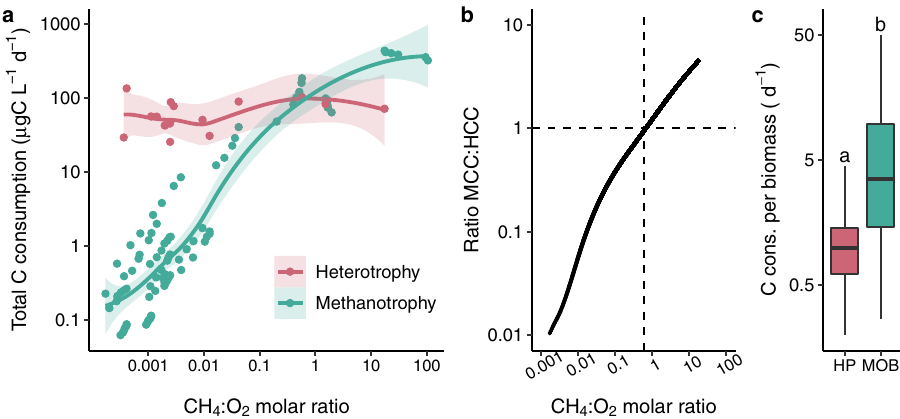
Fig. 2 Methanotrophic and heterotrophic carbon (C) consumption rates measured in incubations. a Total methanotrophic ( n = 93) and heterotrophic ( n = 16) C consumption along the gradient in CH 4 :O 2 molar ratio. Plotted trend lines are loess curves and shaded area around lines indicates 95% con fi dence interval. b Ratio between total methanotrophic and heterotrophic C consumption (MCC and HCC, respectively) – calculated on the predicted values of the loess curves in a – along the gradient in CH 4 :O 2 molar ratio. The dashed horizontal line indicates MCC = HCC and the dashed vertical line crosses the x axis at 0.6. c C consumption per unit biomass (speci fi c activity) of methane-oxidizing bacteria (MOB) ( n = 31) and heterotrophic prokaryotes (HP) ( n = 16). Boxplots represent median, fi rst and third quartiles (hinges), and 1.5 x interquartile range (whiskers). Different letters indicate statistical difference ( p = 0.002, two-sided t -test ( t = − 3.3, d.f. = 30.8)). Note log scale of both axes in a and b , and of y axis in c